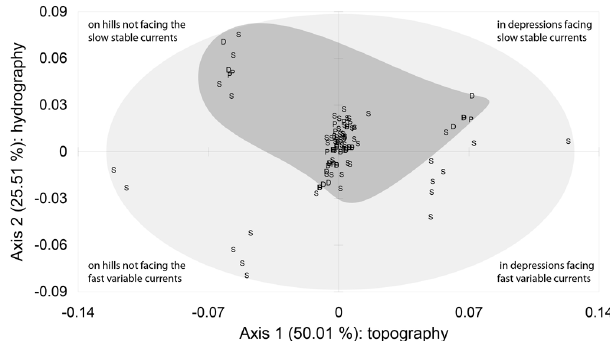
Fig. 4. Environmental control of functional guild assembly. Mobile scavenging detritivore (D) and predator (P) species were distributed across more narrow environmental niches (dark grey shaded area) than sessile filter and suspension feeders (S), the latter of which were found across all sets of topographic and hydrographic con- ditions (light grey shaded area). Mobile fauna inhabited sites with slower, less dynamic currents, while sessile fauna colonised every type of habitat at the